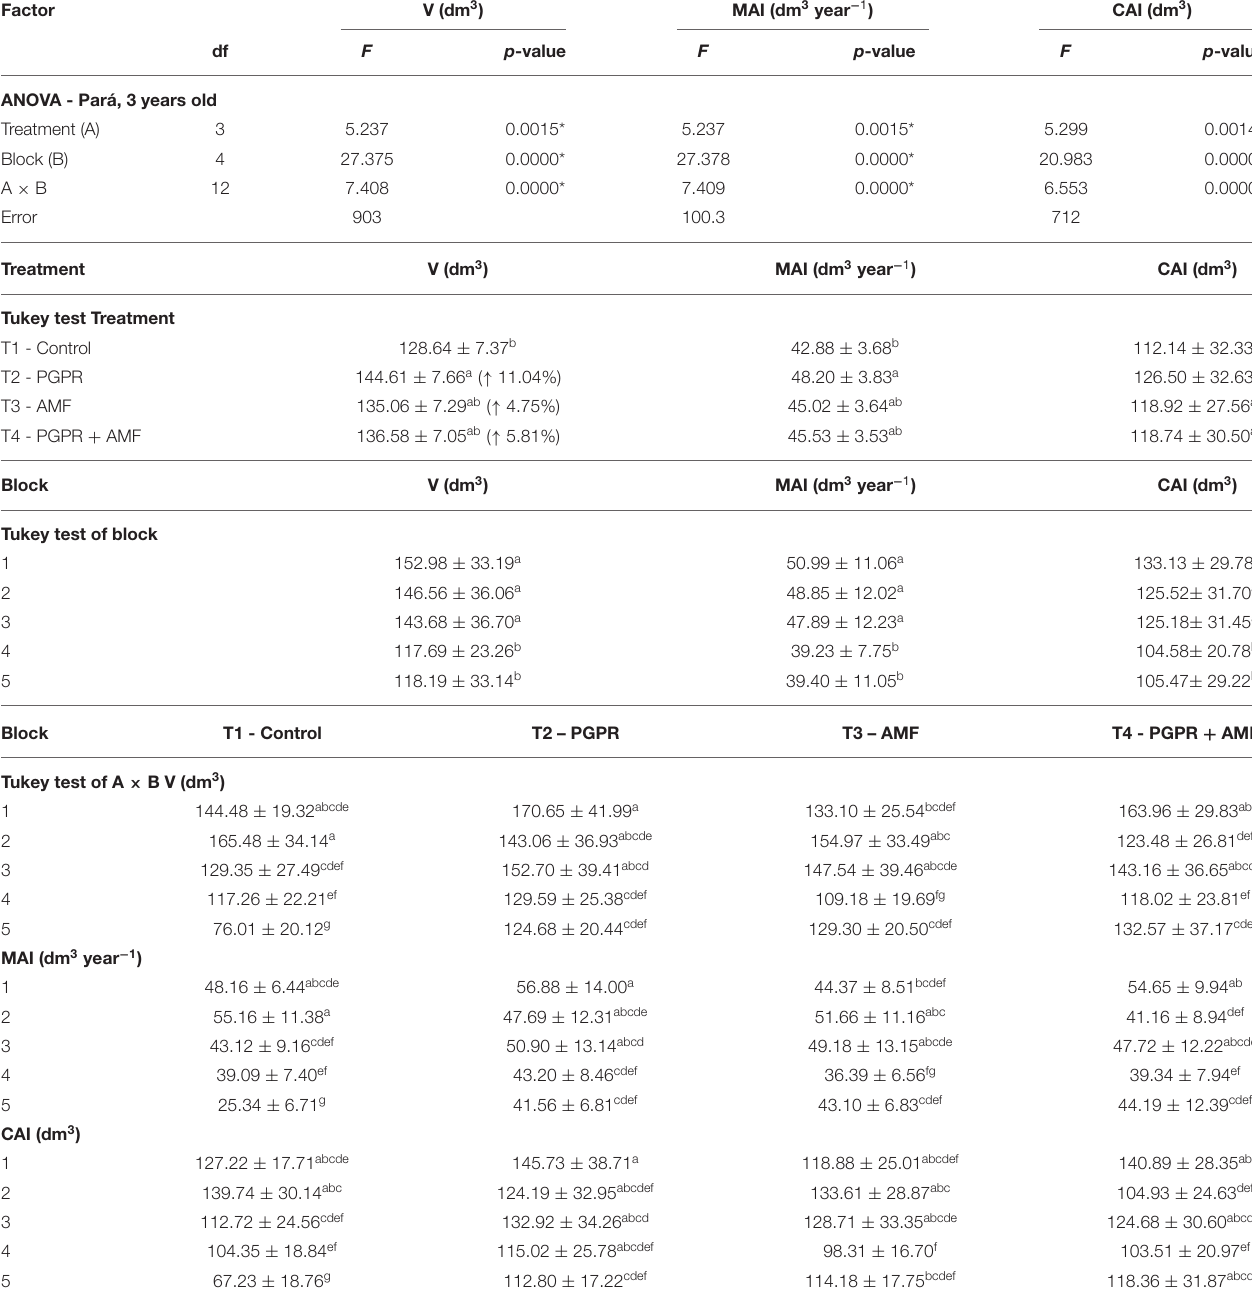
TABLE 9 | Tree volume, mean annual increment, and current annual increment at 3 years old in plants of Tectona grandis in Pará state, Brazil.